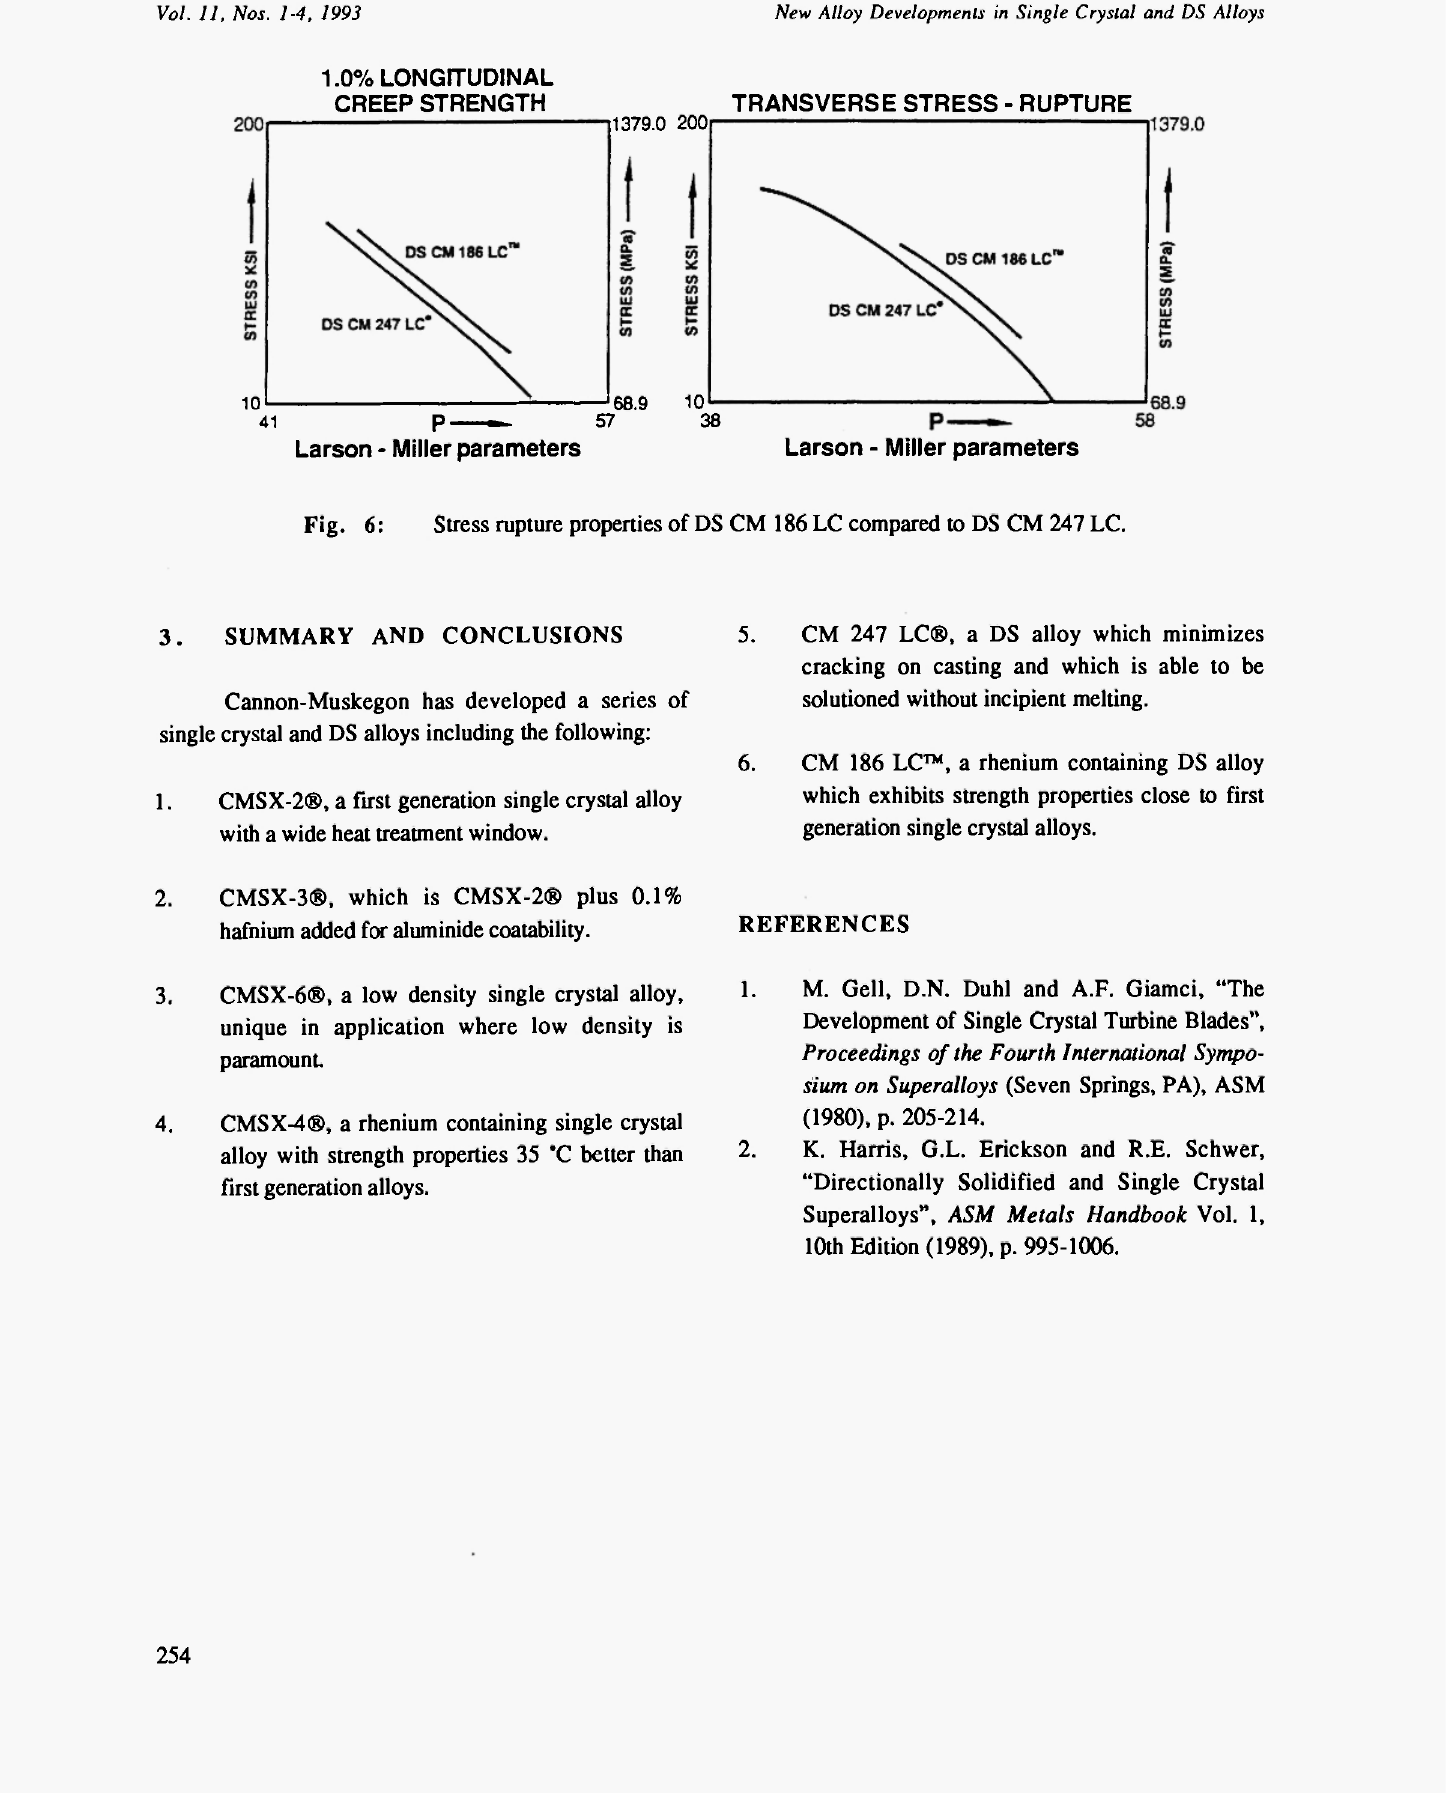
Fig. 6: Stress rupture properties of DS CM 186 LC compared to DS CM 247